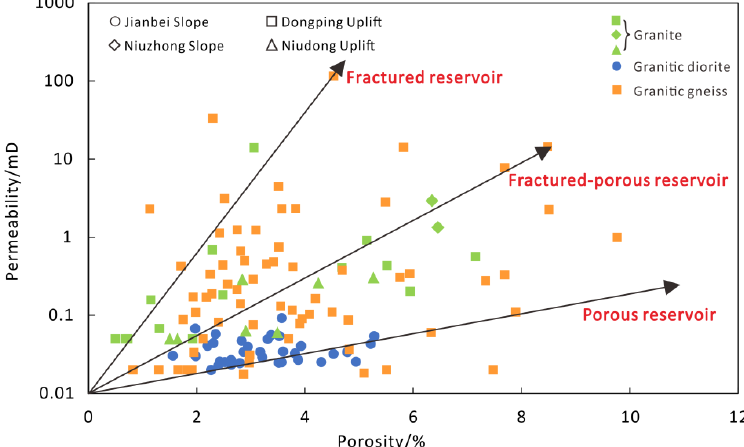
Figure 7. Cross-plot of the relationship between porosity and permeability of core samples from Qinghai oilfield.